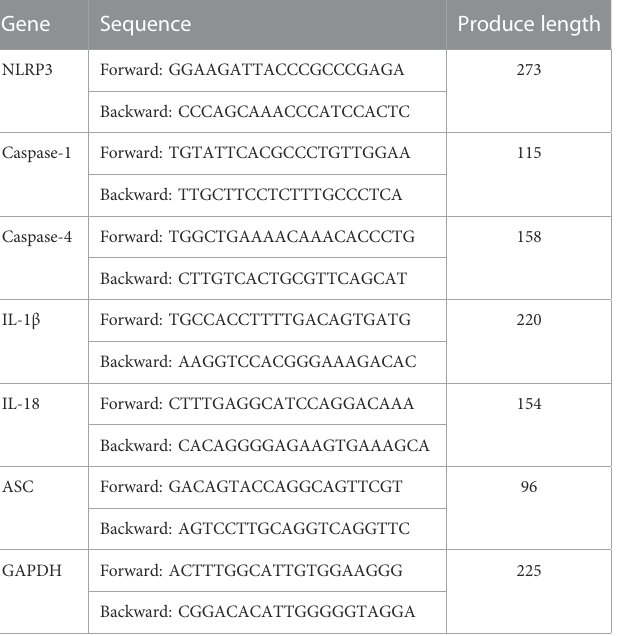
TABLE 1 Primer used for RT-qPCR.